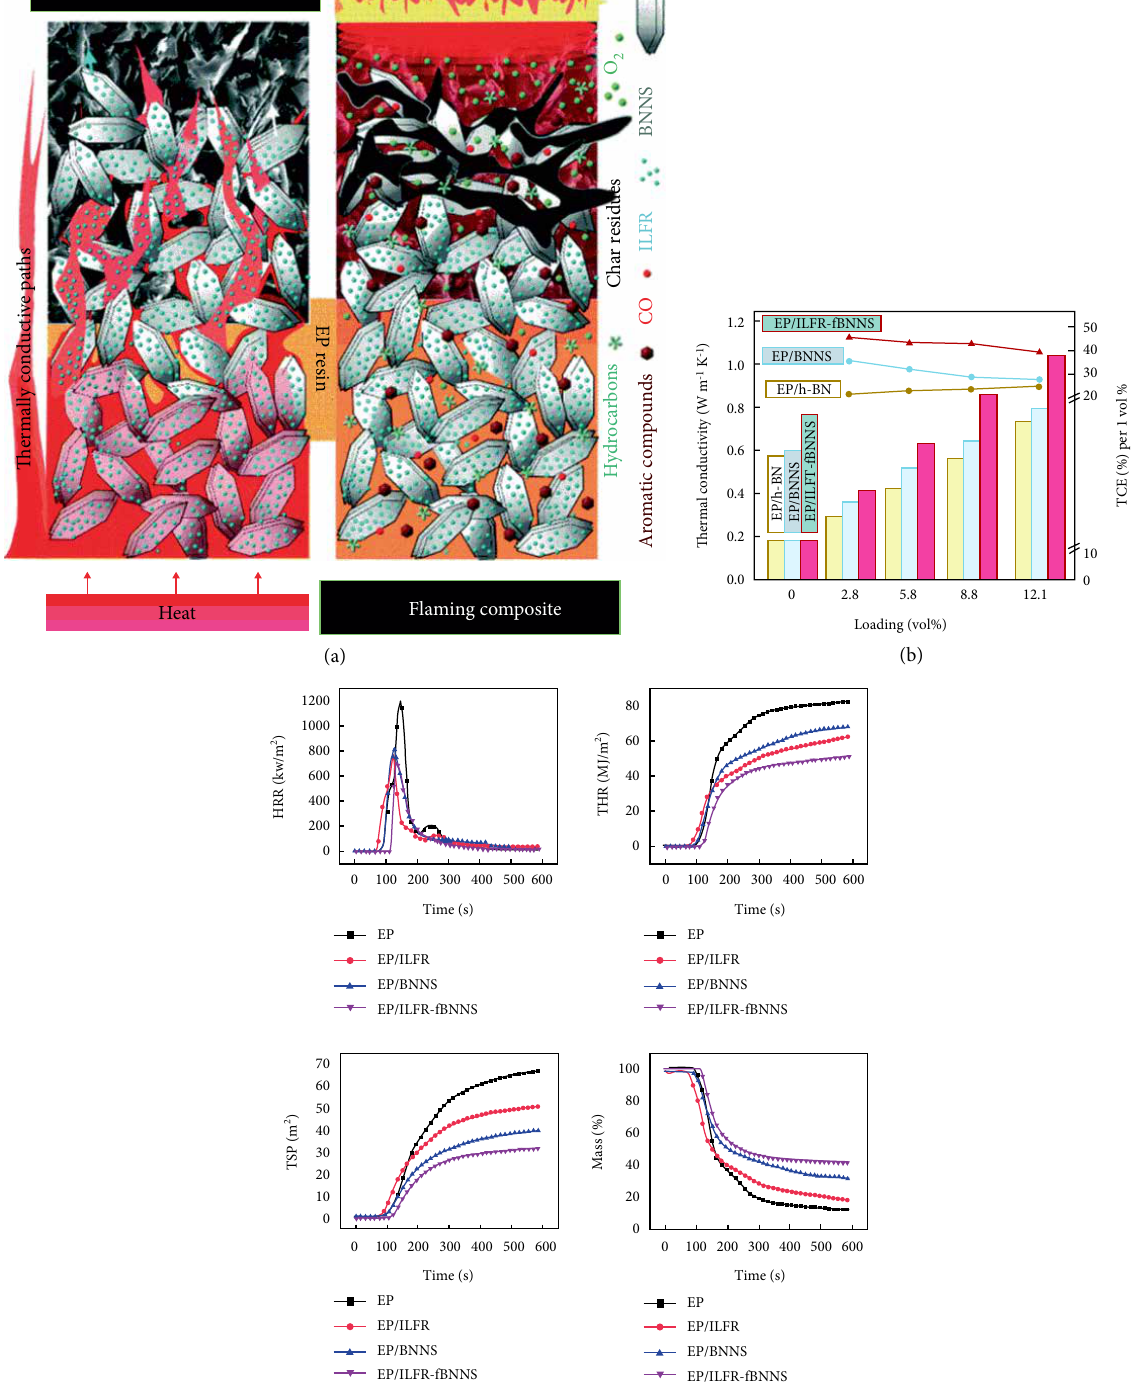
Figure 5: (a) Schematic illustration of thermal conduction and flame retardation mechanisms of EP/ILFR-fBNNS nanocomposites. (b) Thermal conductivity of EP/h-BN, EP/BNNS, and EP/ILFR-fBNNS composites. (c) The HRR, THR, TSP, and mass loss versus time curves of neat EP, EP/ILFR, EP/BNNS 12.1% vol and EP/ILFR-fBNNS 12.1% vol samples obtained from cone calorimeter tests. Adapted from